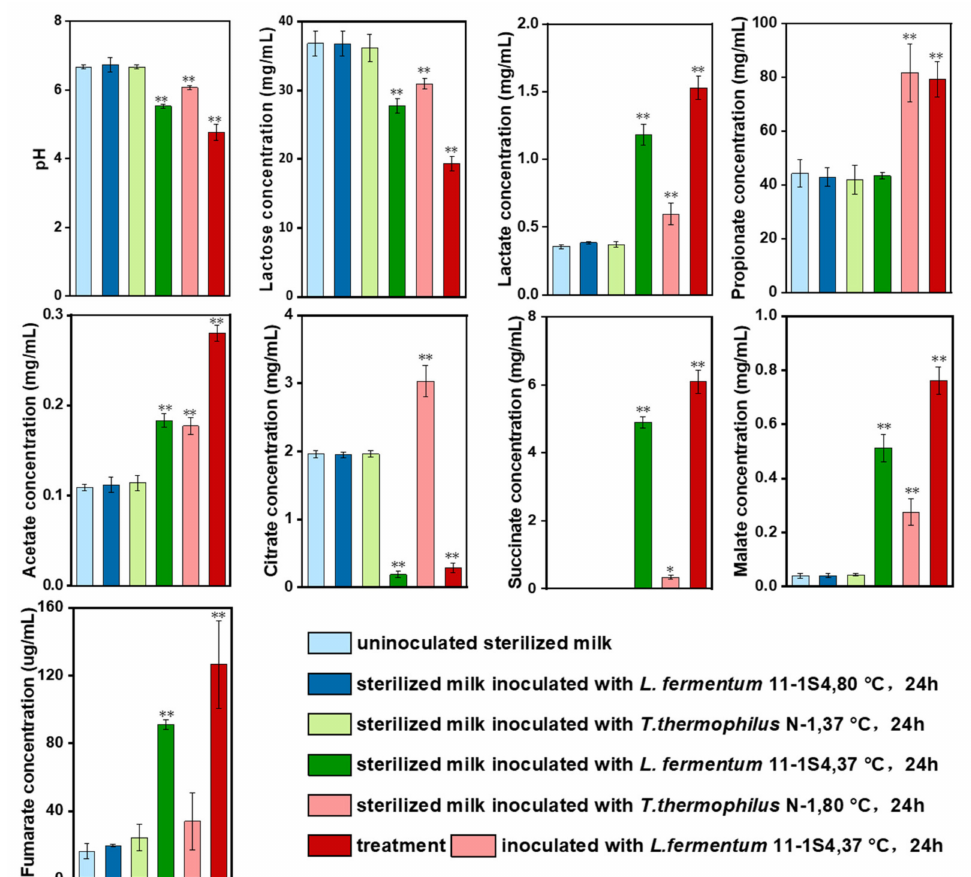
Figure 5. Validation of T. thermophilus N-1 fermentation in milk, including the pH change, lactose metabolism, and organic acid generation. *, ** indicate significant difference at p < 0.05 and p < 0.01 compared with the uninoculated sterilised